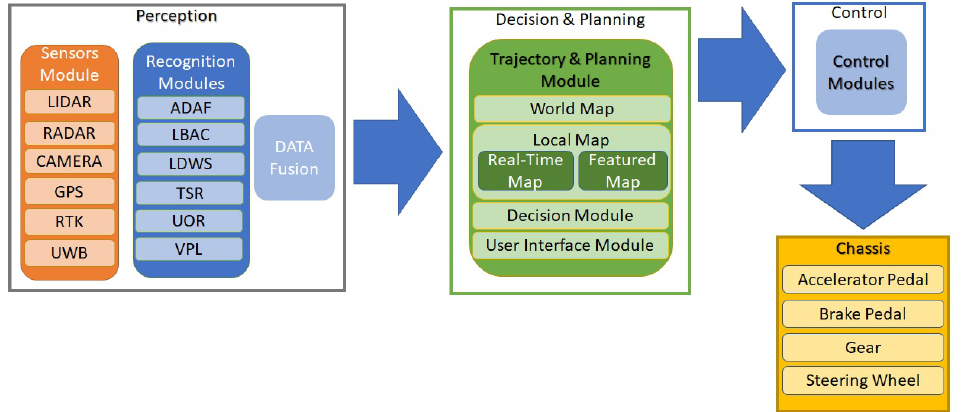
Figure 4. System Architecture for